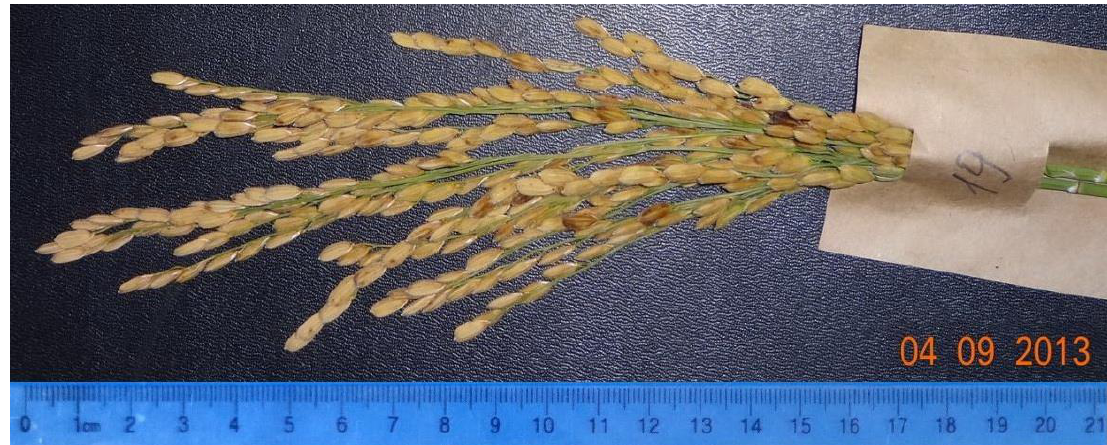
Figure 2. Panicle of the mid-ripening line 1396/13.